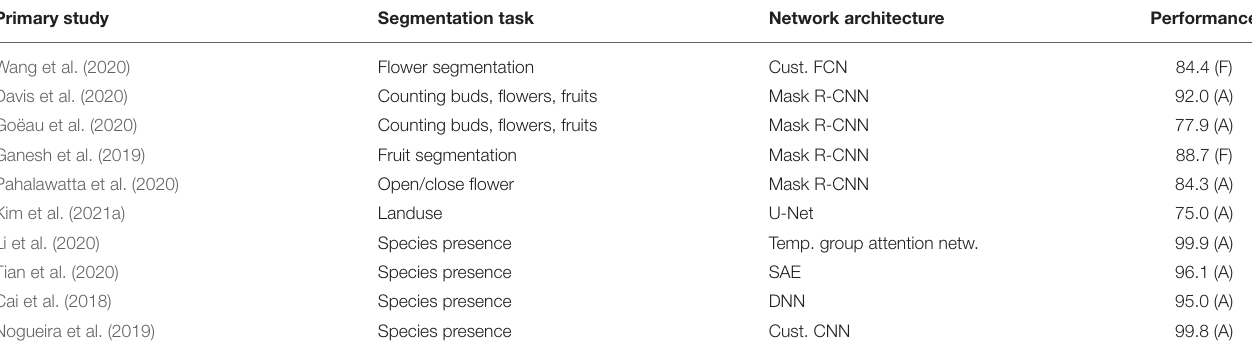
TABLE 6 | Overview of deep learning methods in segmentation tasks.